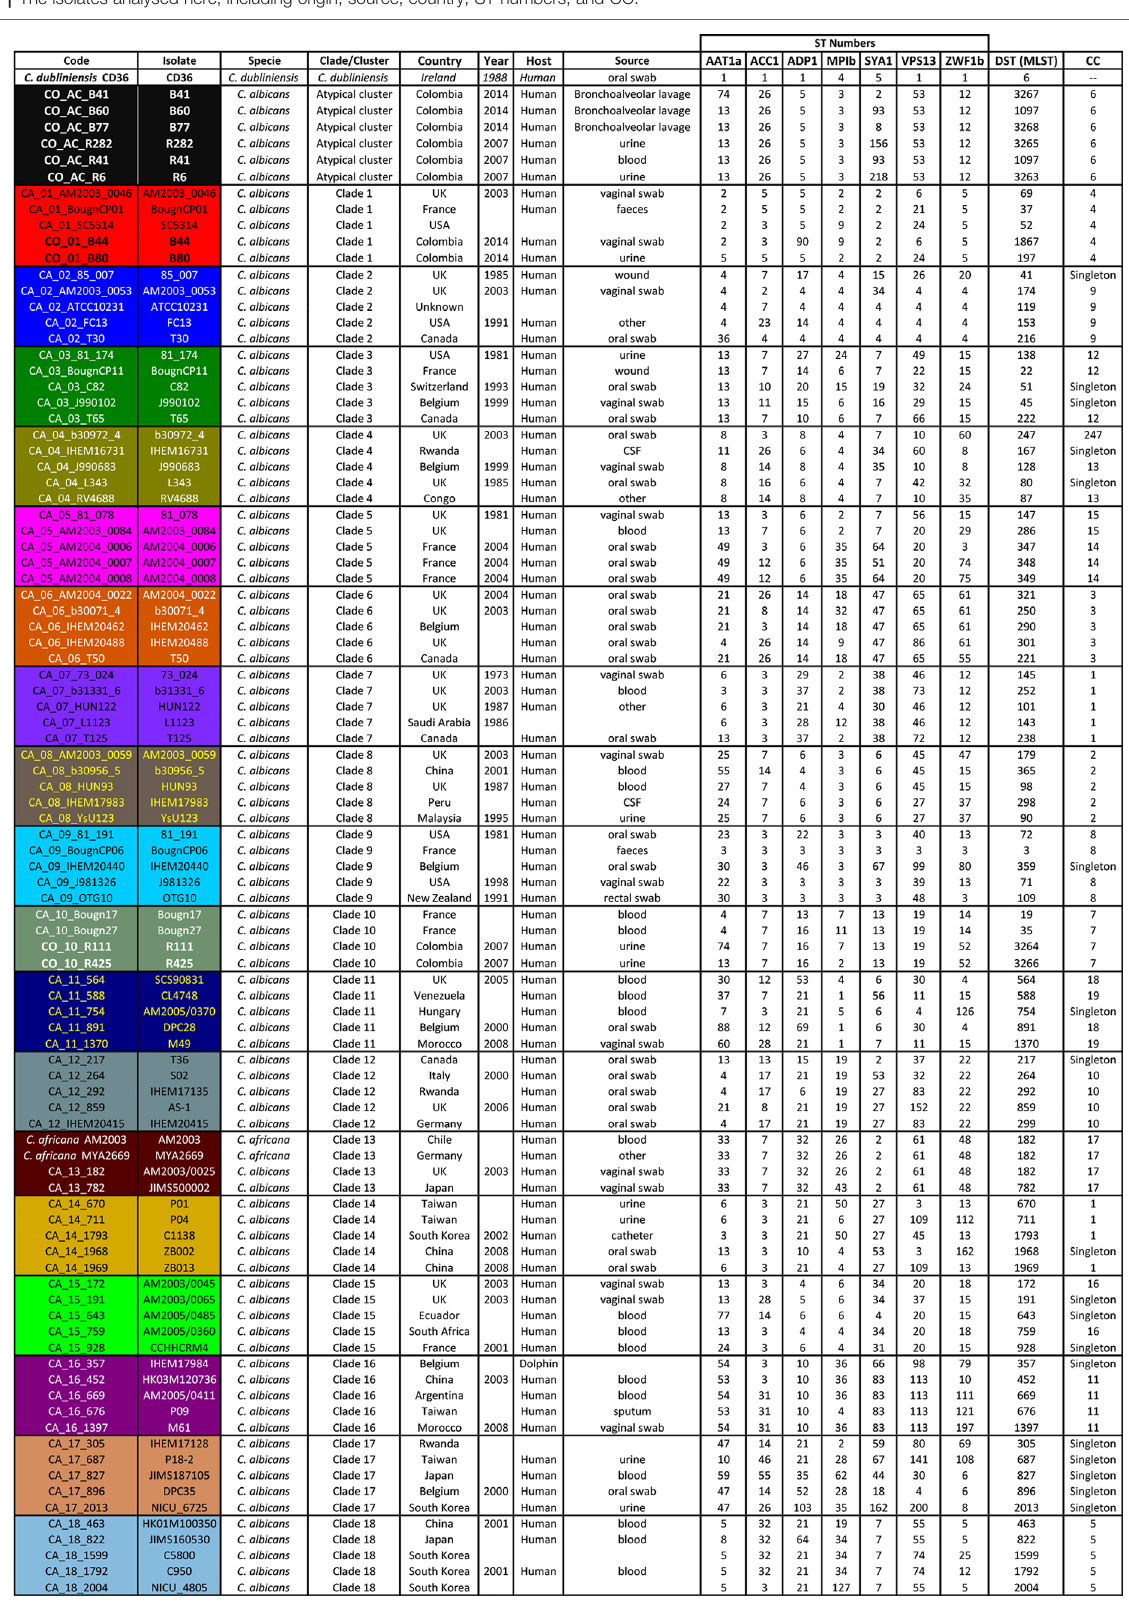
TABLE 1 | The isolates analysed here, including origin, source, country, ST numbers,